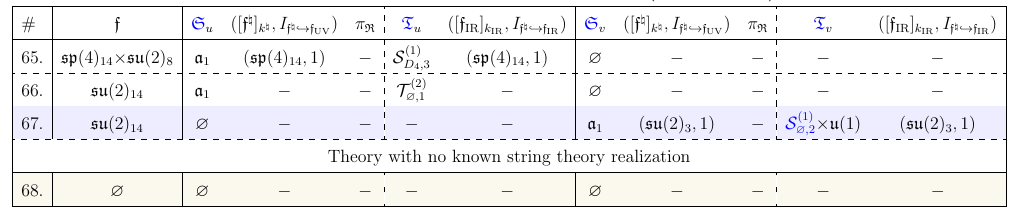
Table 7 . This is the first of three tables summarizing the HB data for rank-2 theories. The second column lists the flavor symmetry of the SCFT, while the rest lists the information of the higgsing of the flavor symmetry realized on bottom symplectic leaves which is indicated under the column . u (1) factors in this table will be mostly S u/v